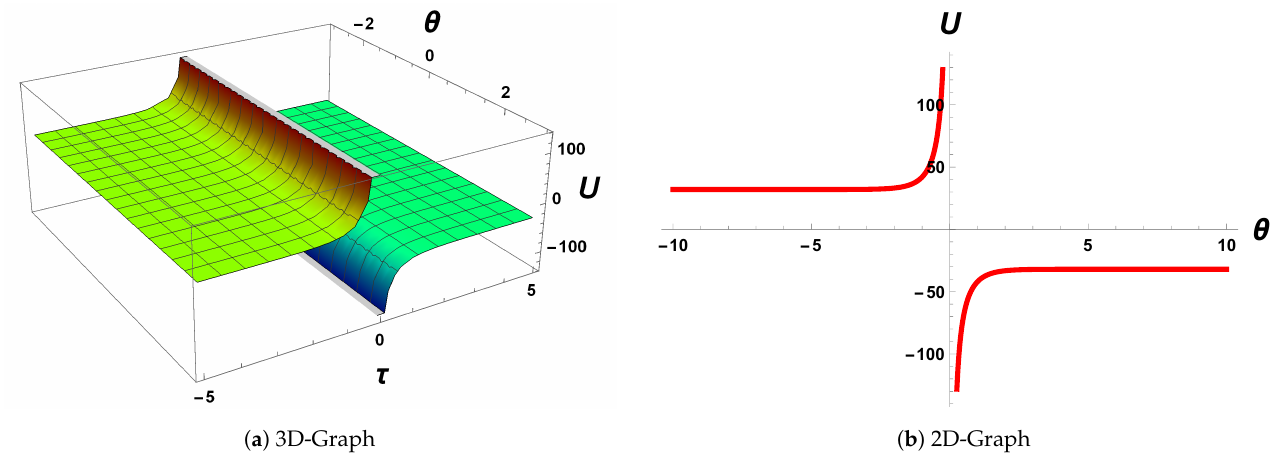
Figure 5. Diagrams a − 3 D and b − 2 D representation of U 6 ( θ , τ ) for l 1 = 0.25, l 2 = 0.50, δ = 0.25, γ 1 = 1.5, γ 2 = 0.10, and γ 3 =